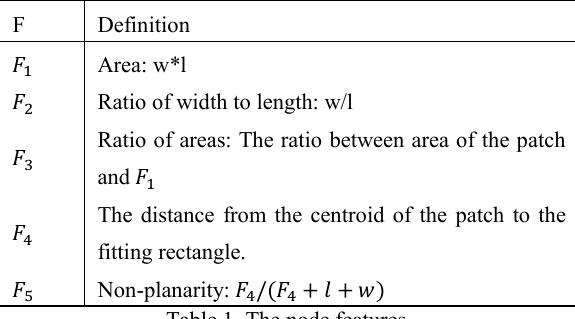
Table 1. The node features.